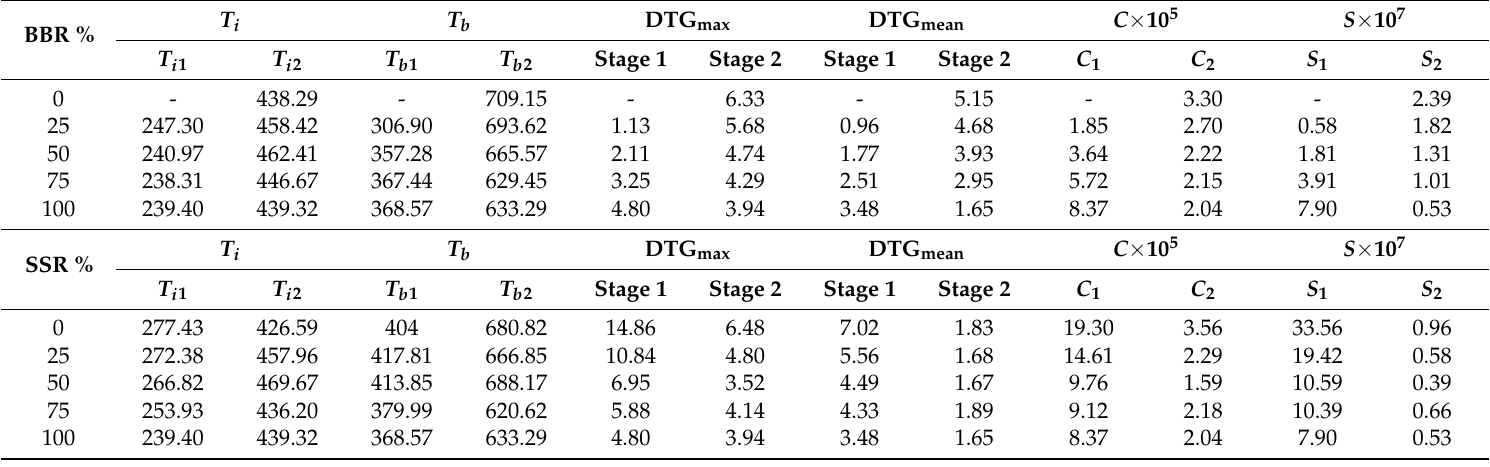
Table 3. Combustion characteristics for different sludge-coal ratios (BBR) and sludge-shiitake ratios (SSR) (BBR = SSR = 100%: pure